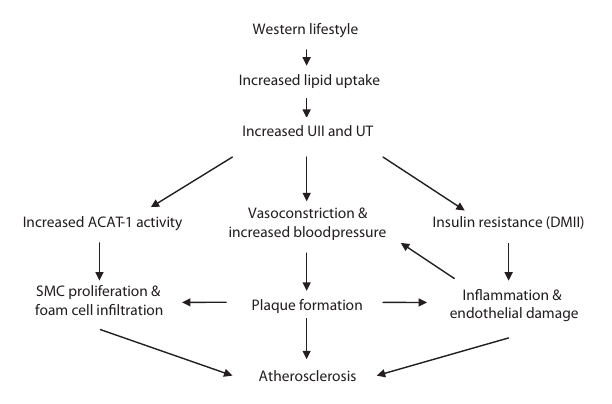
FIGURE 1 | Schematic representation of the potential role of UII in the pathogenesis of atherosclerosis. The high-fat diet associated with a Western lifestyle results in the upregulation of UII and the UT receptor expression. UII is known to inhibit insulin release and may contribute to the development of the metabolic syndrome.The resulting inflammation and endothelial damage leads to kidney injury which in turn increases blood pressure. Cardiovascular disease ensues by the formation of the atherosclerotic plaques. SMC proliferate and macrophages infiltrate at these lesions, enhanced by ACAT-1